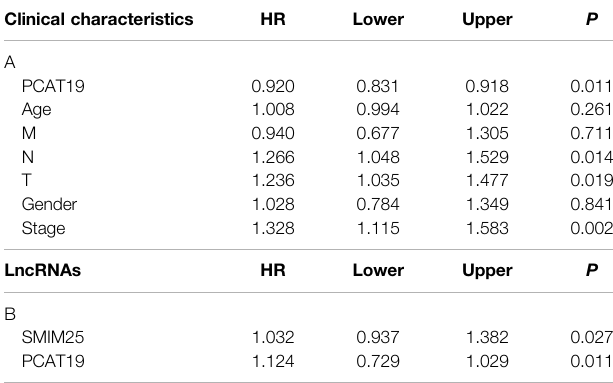
TABLE 4 | (A) Correlation between overall survival and multivariable characteristics via multivariatesurvivalanalysisofPCAT19and (B) multivariate survival analysis of SMIM25 and